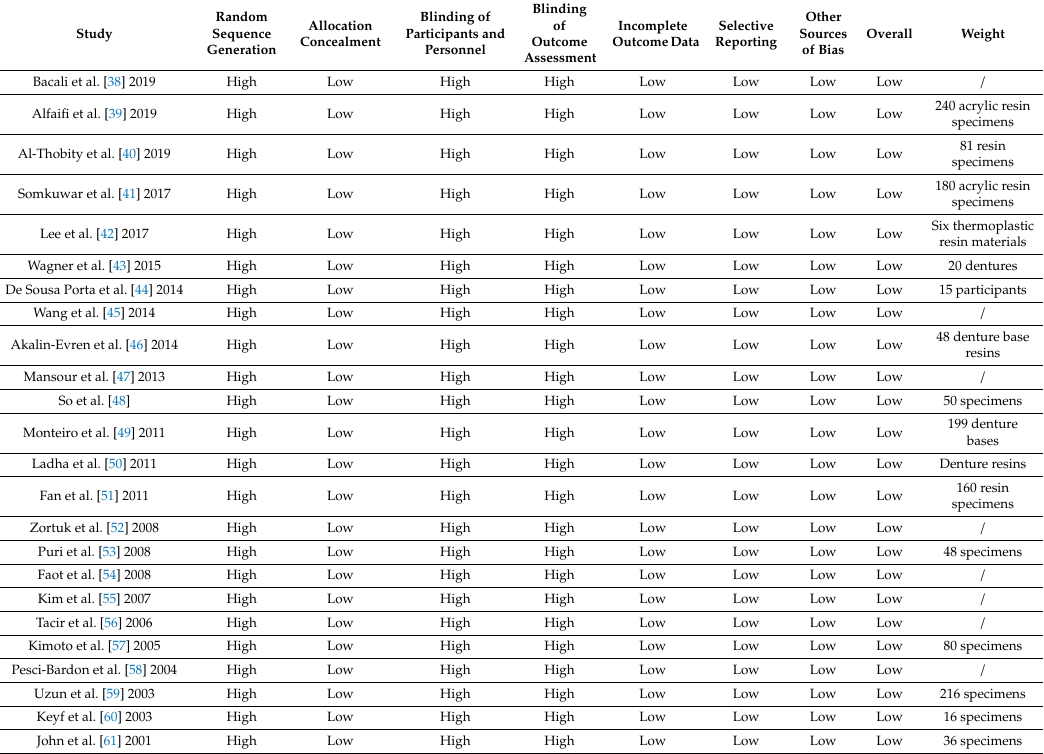
Table 2. Risk of bias table according to ROBIS.